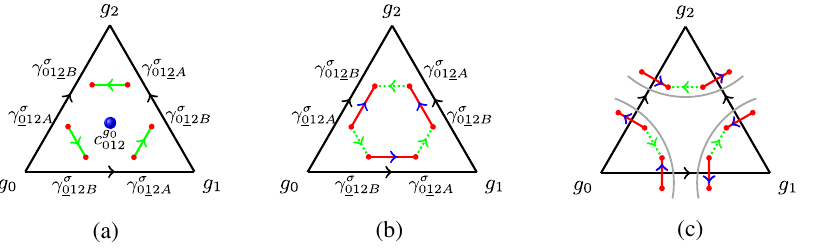
U 1 U 2 ð b Þ ! ð c Þ to